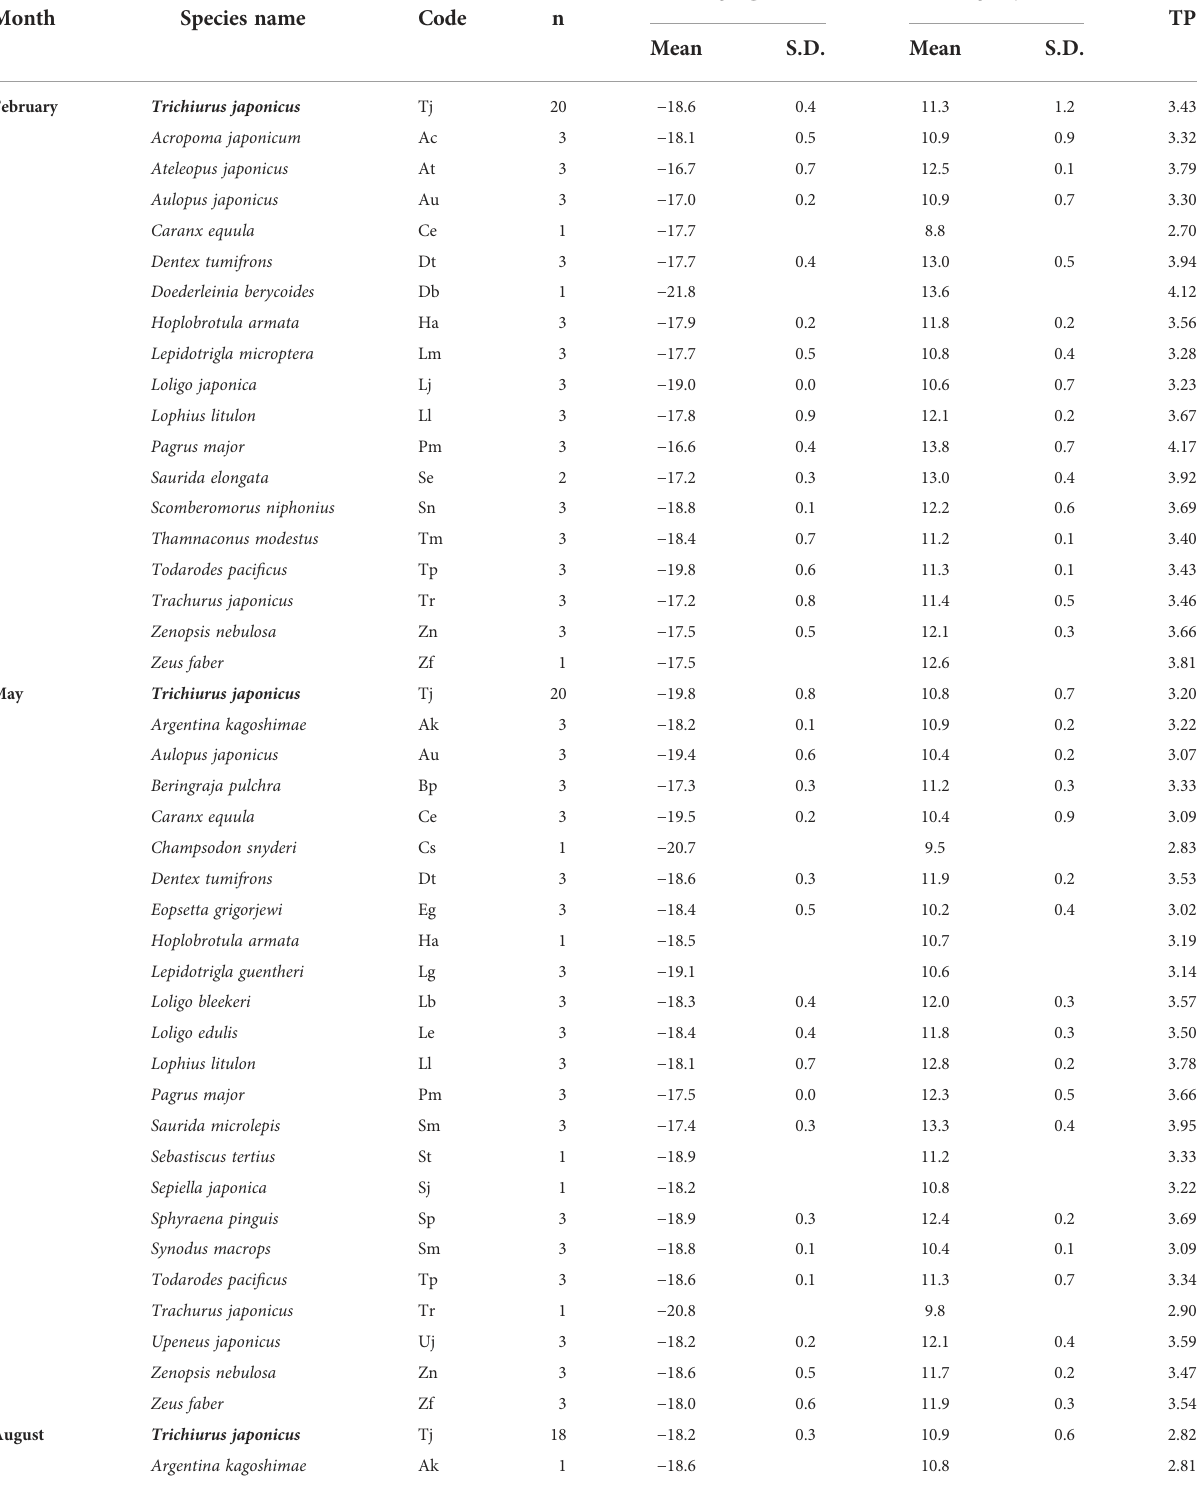
TABLE 3 d 13 C and d 15 N values and trophic position (TP) of large-head hairtail Trichiurus japonicus and other fi sh consumers collected during February, May, August, and November 2021 in the South Sea of Korea.